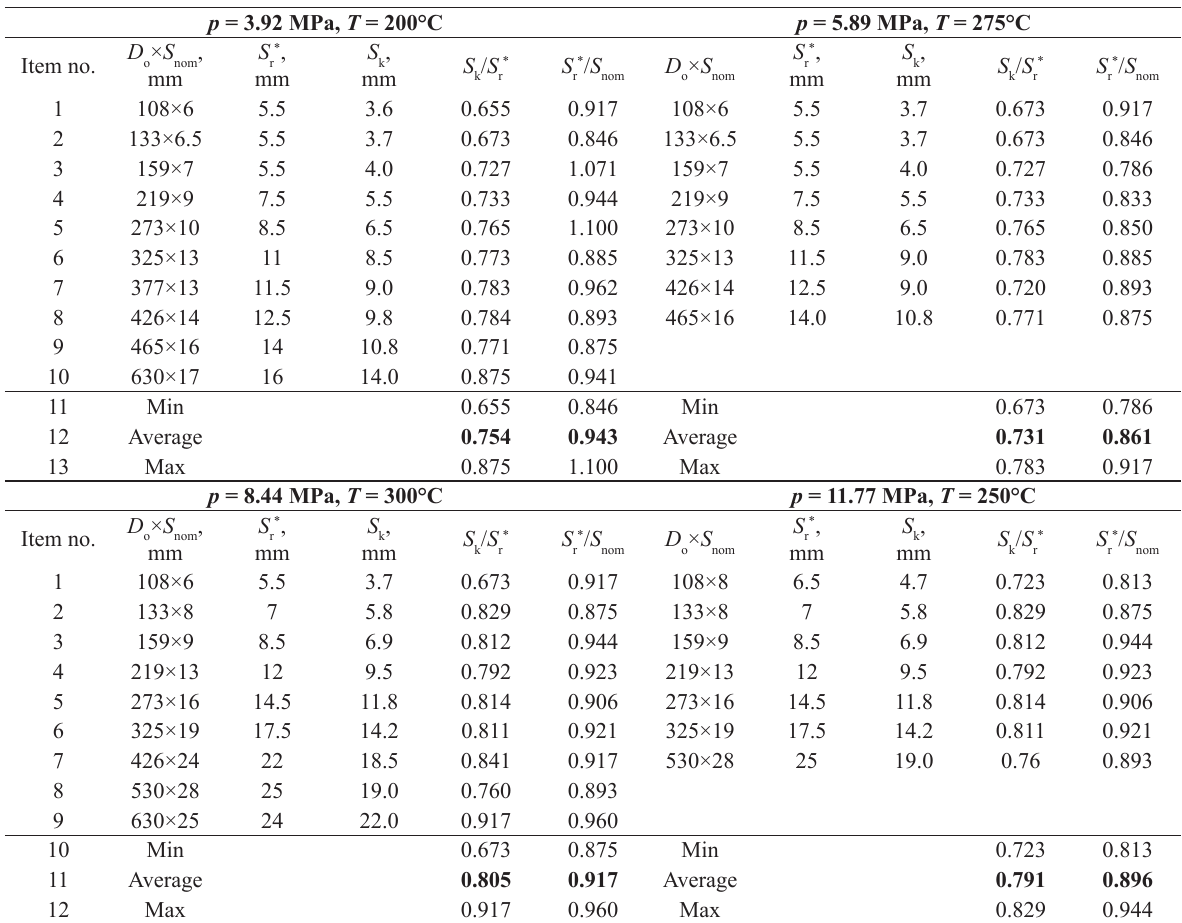
/ S r* for control pressure and tem- k